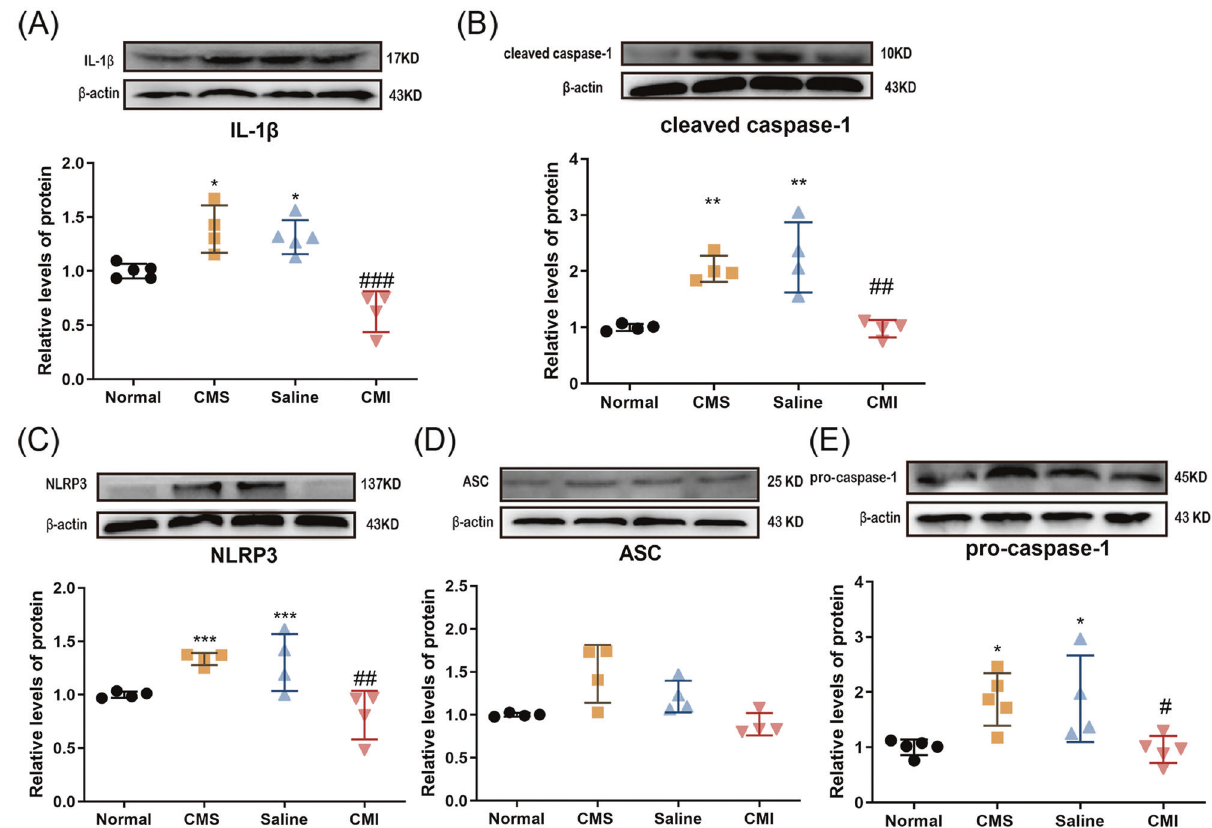
Fig. 3 The effect of chronic clomipramine treatment on the hippocampal NLRP3 in fl ammasome level in the CMS-treated rats. The protein levels of A IL-1 β , B cleaved caspase-1, C NLRP3, D ASC, and E pro-caspase-1 ( n = 4/group) were analyzed by western blot. All data are expressed as the mean ± SD. ## p < 0.01, ### p < 0.001 compared to saline-treated rats. * p < 0.05, ** p <0.01, *** p < 0.001 compared to non- stressed control